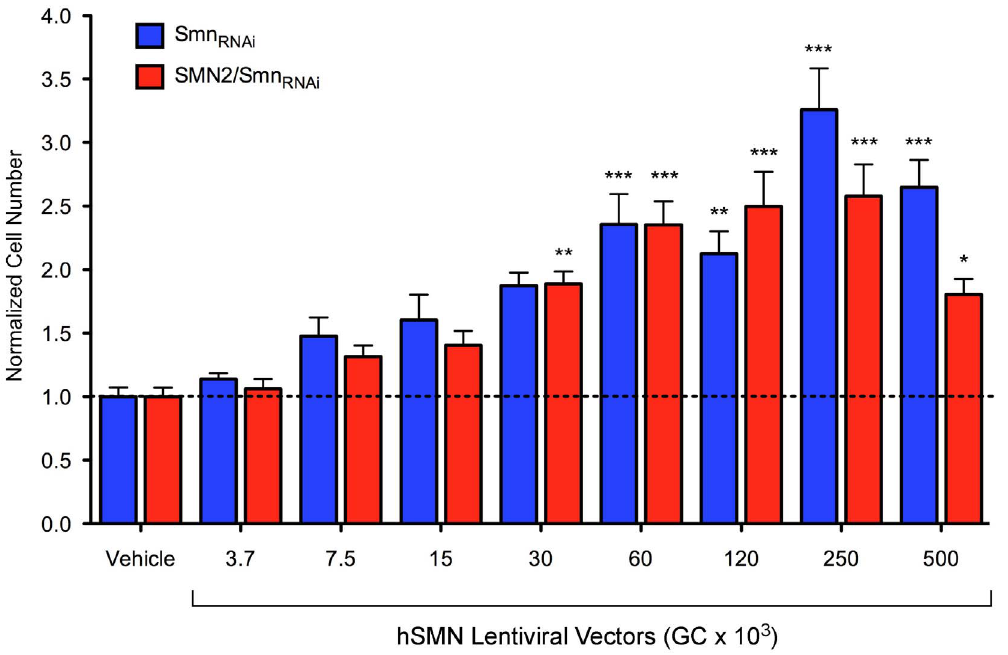
Figure 7. Genetic modulation of SMN-dependent proliferation in NIH3T3 cells. Dose-response analysis of lentiviral-mediated human SMN expression on cell proliferation of SMN-deficient NIH3T3-Smn RNAi and NIH3T3-SMN2 low /Smn RNAi cells. In these experiments, NIH3T3 cells were cultured for 5 days with Dox prior to seeding in six replicate wells of a 96-well plate in the presence of Dox. Vehicle or increasing amounts of SMN- expressing lentivirus were added 4 hours later. For each group and treatment, cell number was determined at 5 days post-plating and normalized to that of the corresponding vehicle-treated cells. Data are represented as mean and SEM (n=6; *=p , 0.05; **=p , 0.01; ***=p , 0.001; one-way